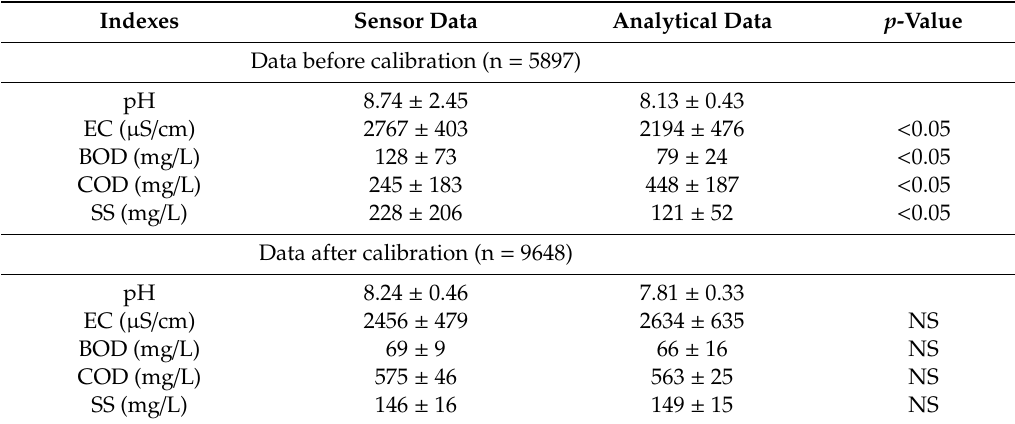
Table 2. Comparison of the effluent water quality indexes before / after calibration of water quality